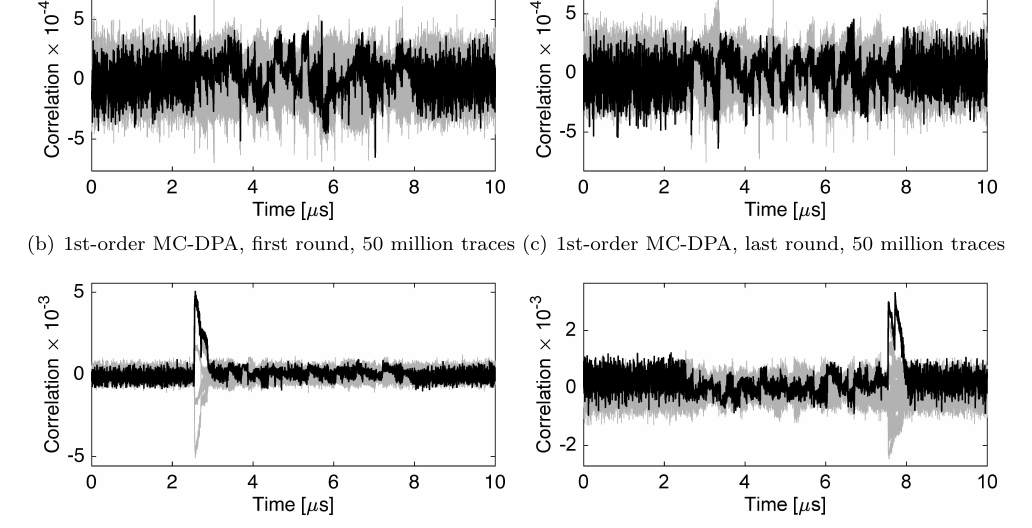
Figure 7: Experimental analysis of our Midori encryption/decryption